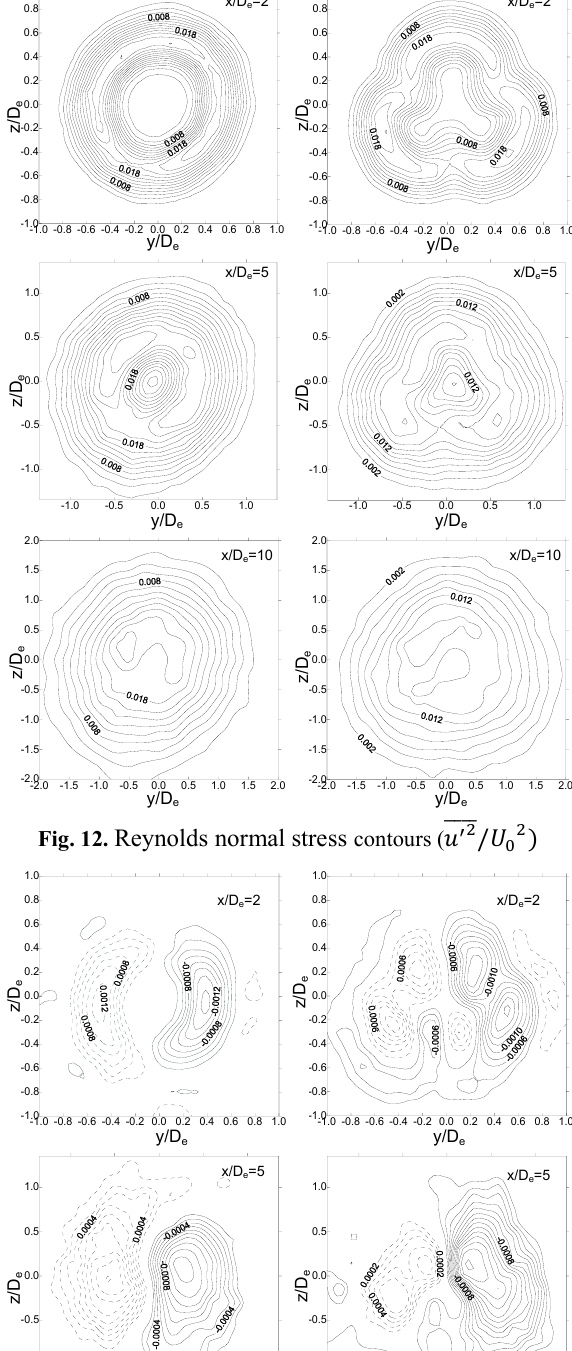
regions match maximum velocity gradients in Figure 6.